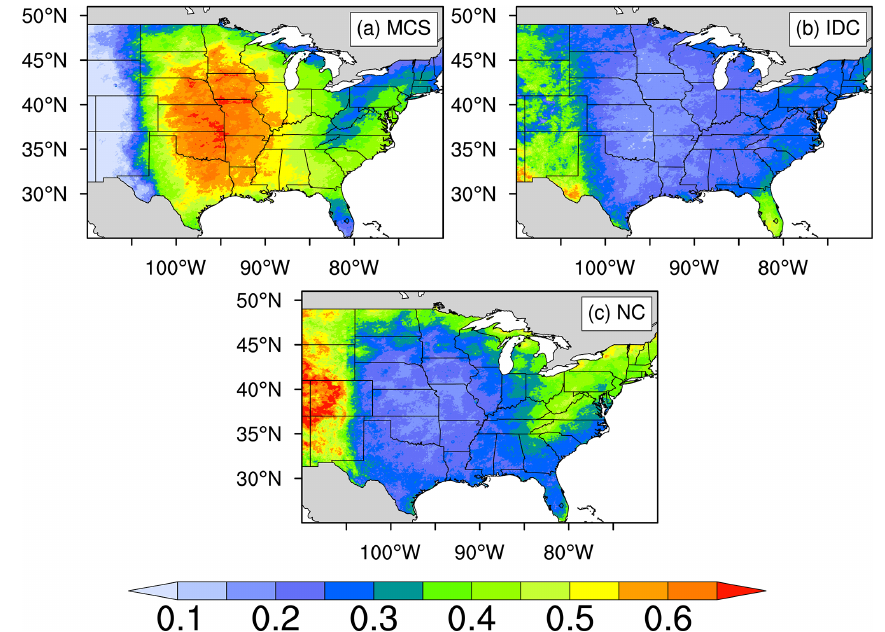
Figure 6. Distributions of the fractions of different types of precipitation (MCS, IDC, NC). Here, precipitation refers to annual mean values for 2004–2017. We exclude hourly data with precipitation ≤ 1mmh − 1 in the